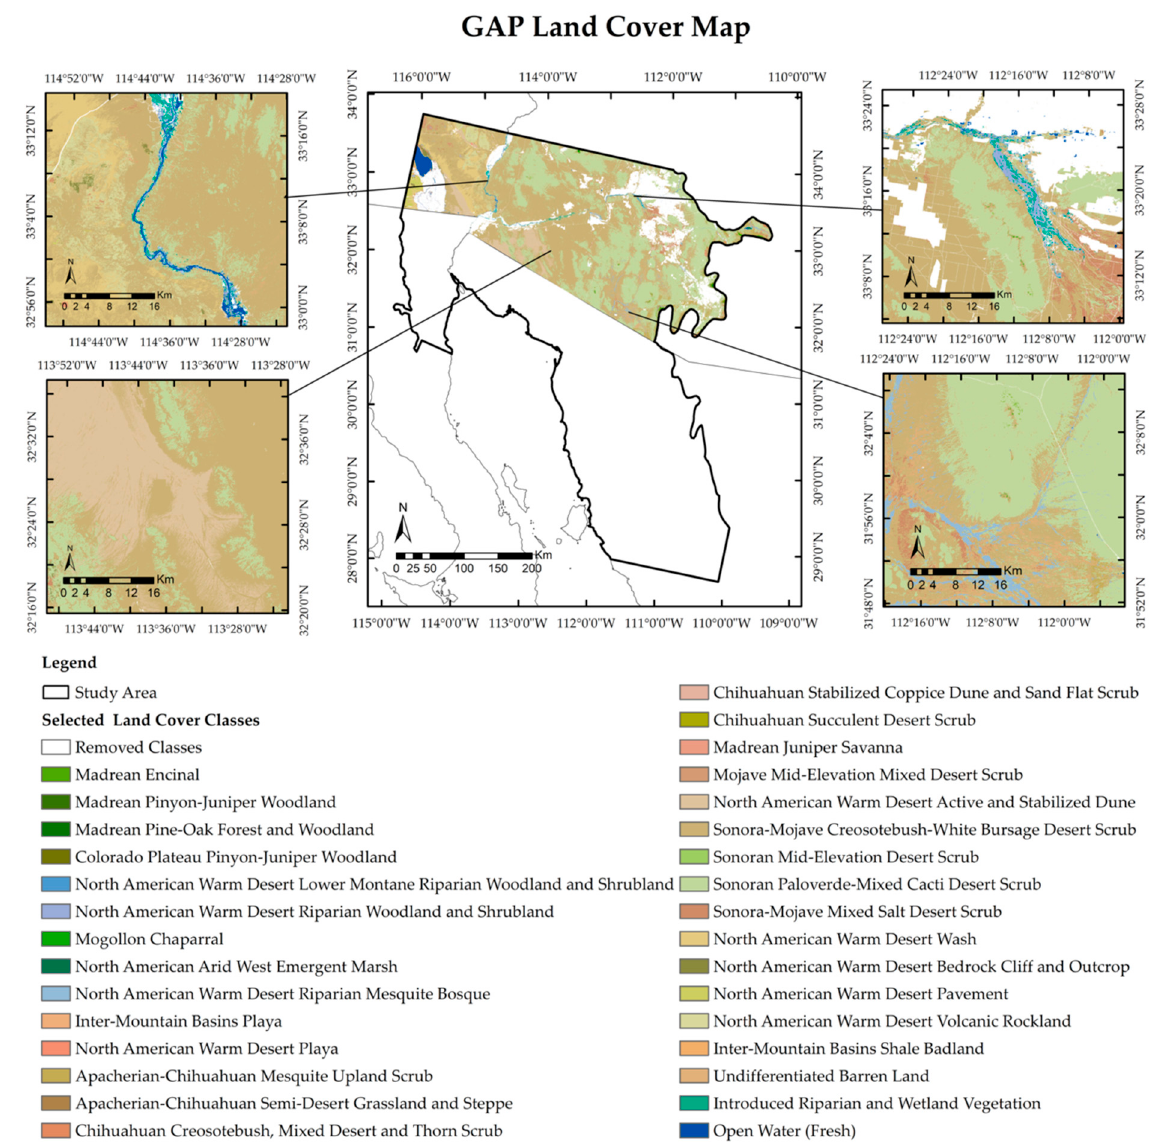
Figure 2. Footprint of the study area showing the selected GAP land cover classes. A total of 31 classes were selected. Classes that were not considered included land cover classes with fewer than 1500 pixels within the study area, Recently Disturbed or Modified land cover, agriculture land, and urban